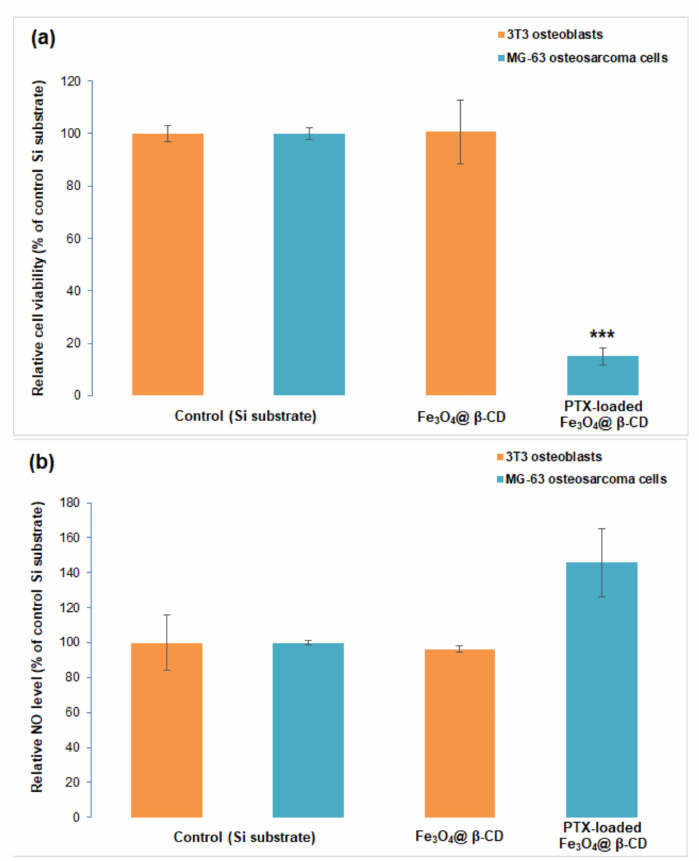
Figure 17. Biocompatibility of Fe 3 O 4 @ β -CD nanoparticles on normal 3T3 osteoblasts ( a ) and anti-tumor efficiency of PTX-loaded Fe 3 O 4 @ β -CD nanocomposites on MG-63 osteosarcoma cells ( b ) evidenced by the results of MTT ( a ) and Griess ( b ) assays. The results were calculated as mean values ( n = 3) and expressed relative to control samples (*** p < 0.001).